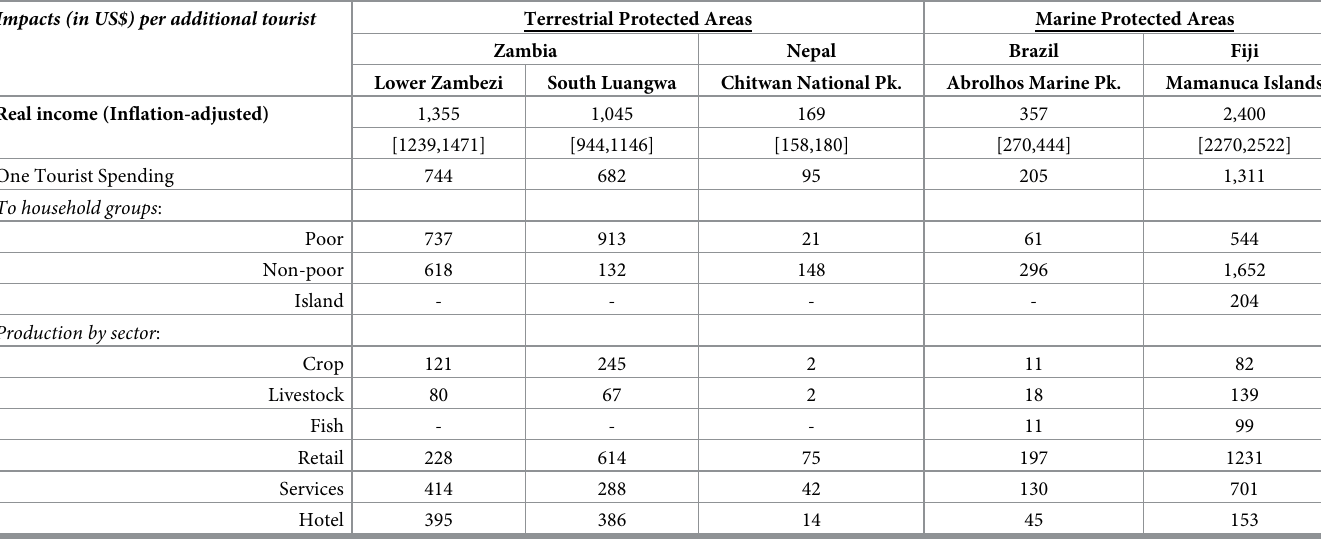
Table 1. Impact of an additional tourist in the five protected areas.